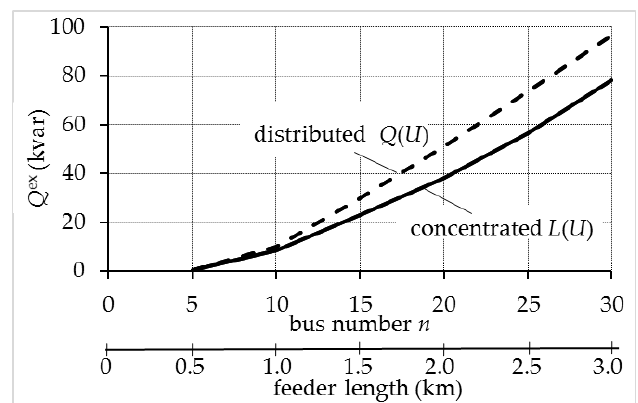
Figure 17. Exchanged reactive power as a function of the bus number or feeder length for the Q ( U ) and L ( U ) control strategies.